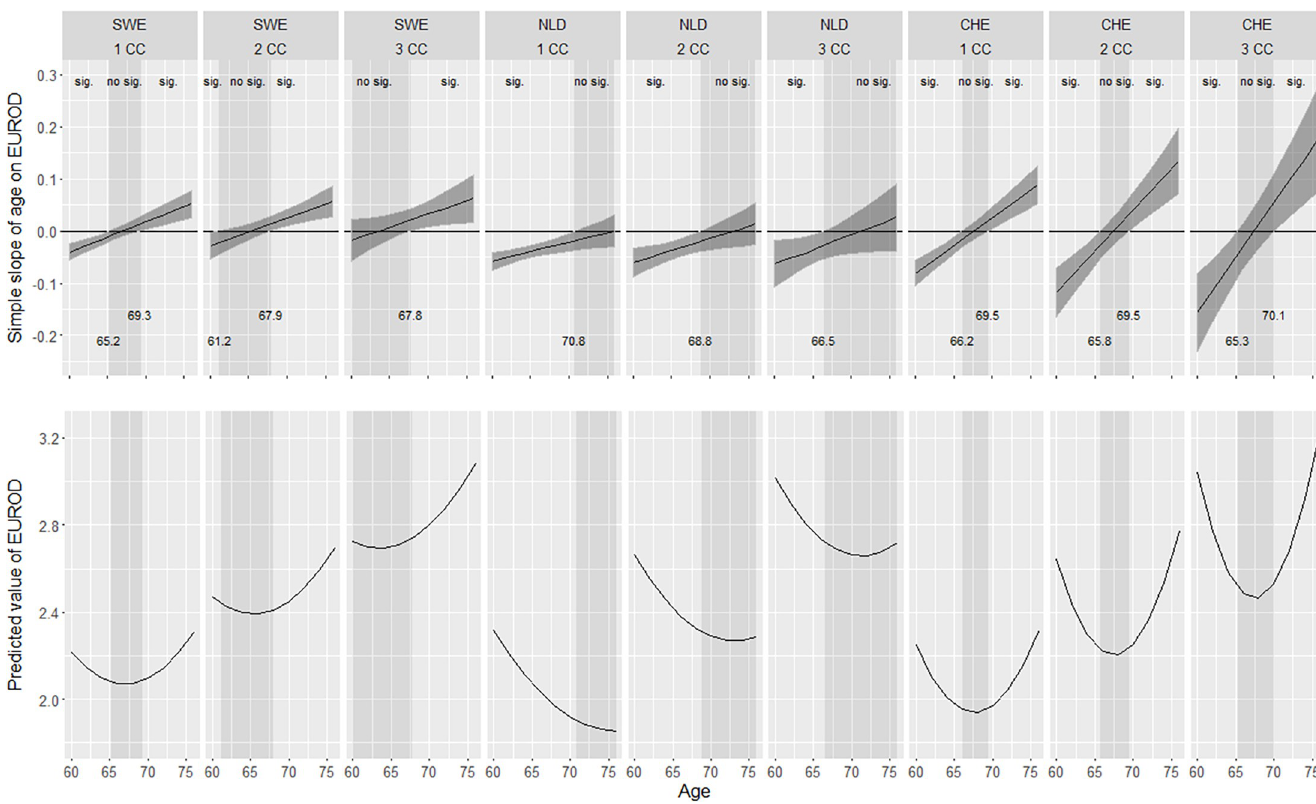
Fig 1. Linear slopes of EURO-D scores for the Netherlands, Sweden and Switzerland for 1–3 chronic conditions and their corresponding confidence regions (top panel) and predicted trajectories for three different placements of the model intercept (bottom panel).